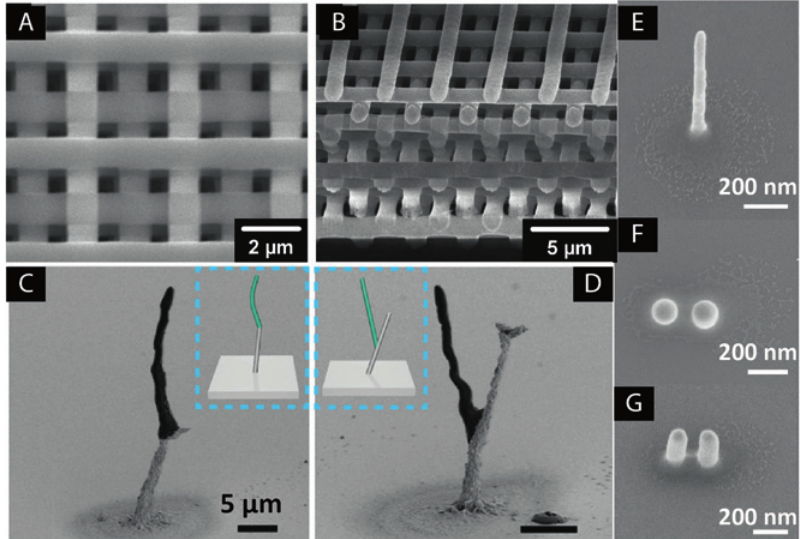
Figure 10: 3D micro and nanostructures fabricated using inkjet printing. (A – B)